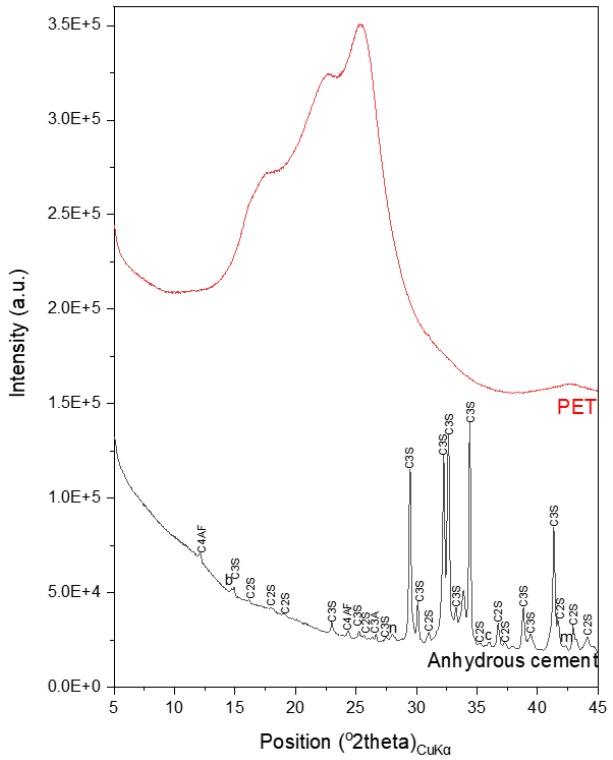
Figure 3. XRD patterns of the cement and the PET powder. Symbols are used to denote b: bassanite; c: calcite; m: periclase; n: thernadite.